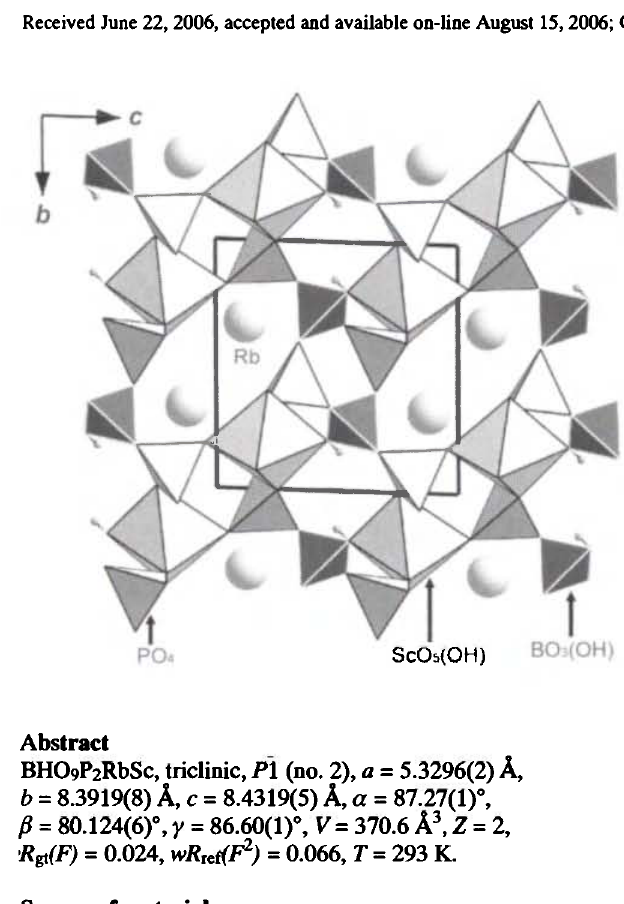
Table 1. Data collection and handling.